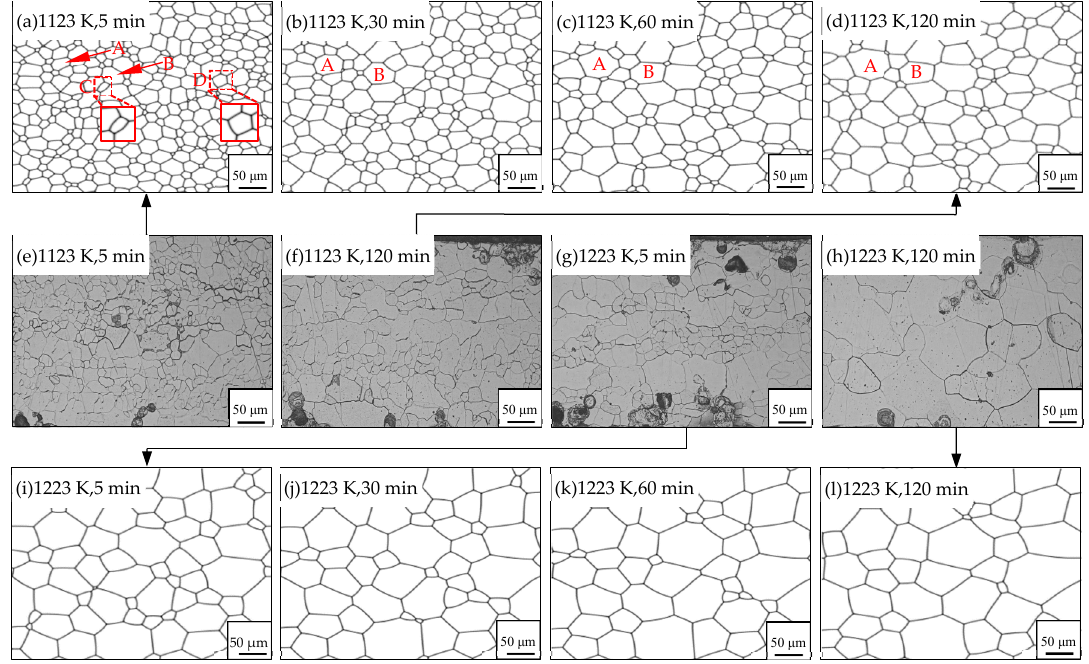
Figure 4. The coarsening process of simulated data and experimental results at 1123 K and 1223 K for 120 min: ( a – d ), ( i – l ), simulated microstructures; ( e – h ): experimental observations.